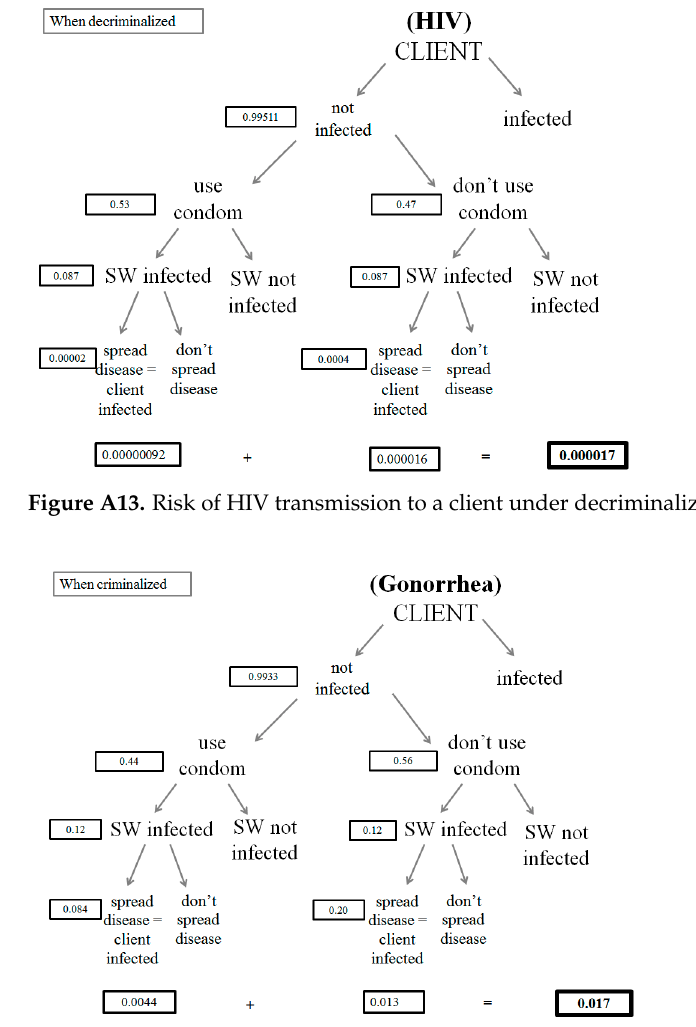
Figure A12. Risk of HIV transmission to a client under criminalization.